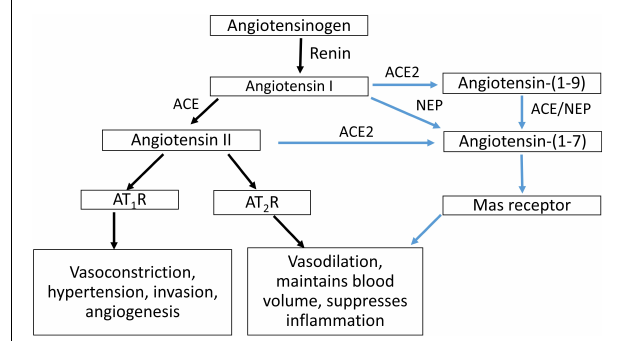
FIGURE 1 | Schematic representation of the RAS cascade. ACE, angiotensin converting enzyme; ACE2, angiotensin converting enzyme 2; NEP, neprilysin; AT 1 R, Angiotensin II type 1 receptor, AT 2 R; Angiotensin II type 2